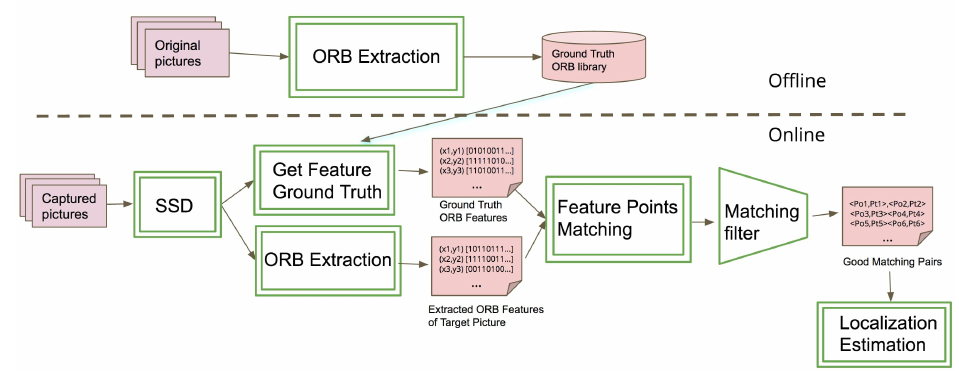
Figure 9. Feature-based